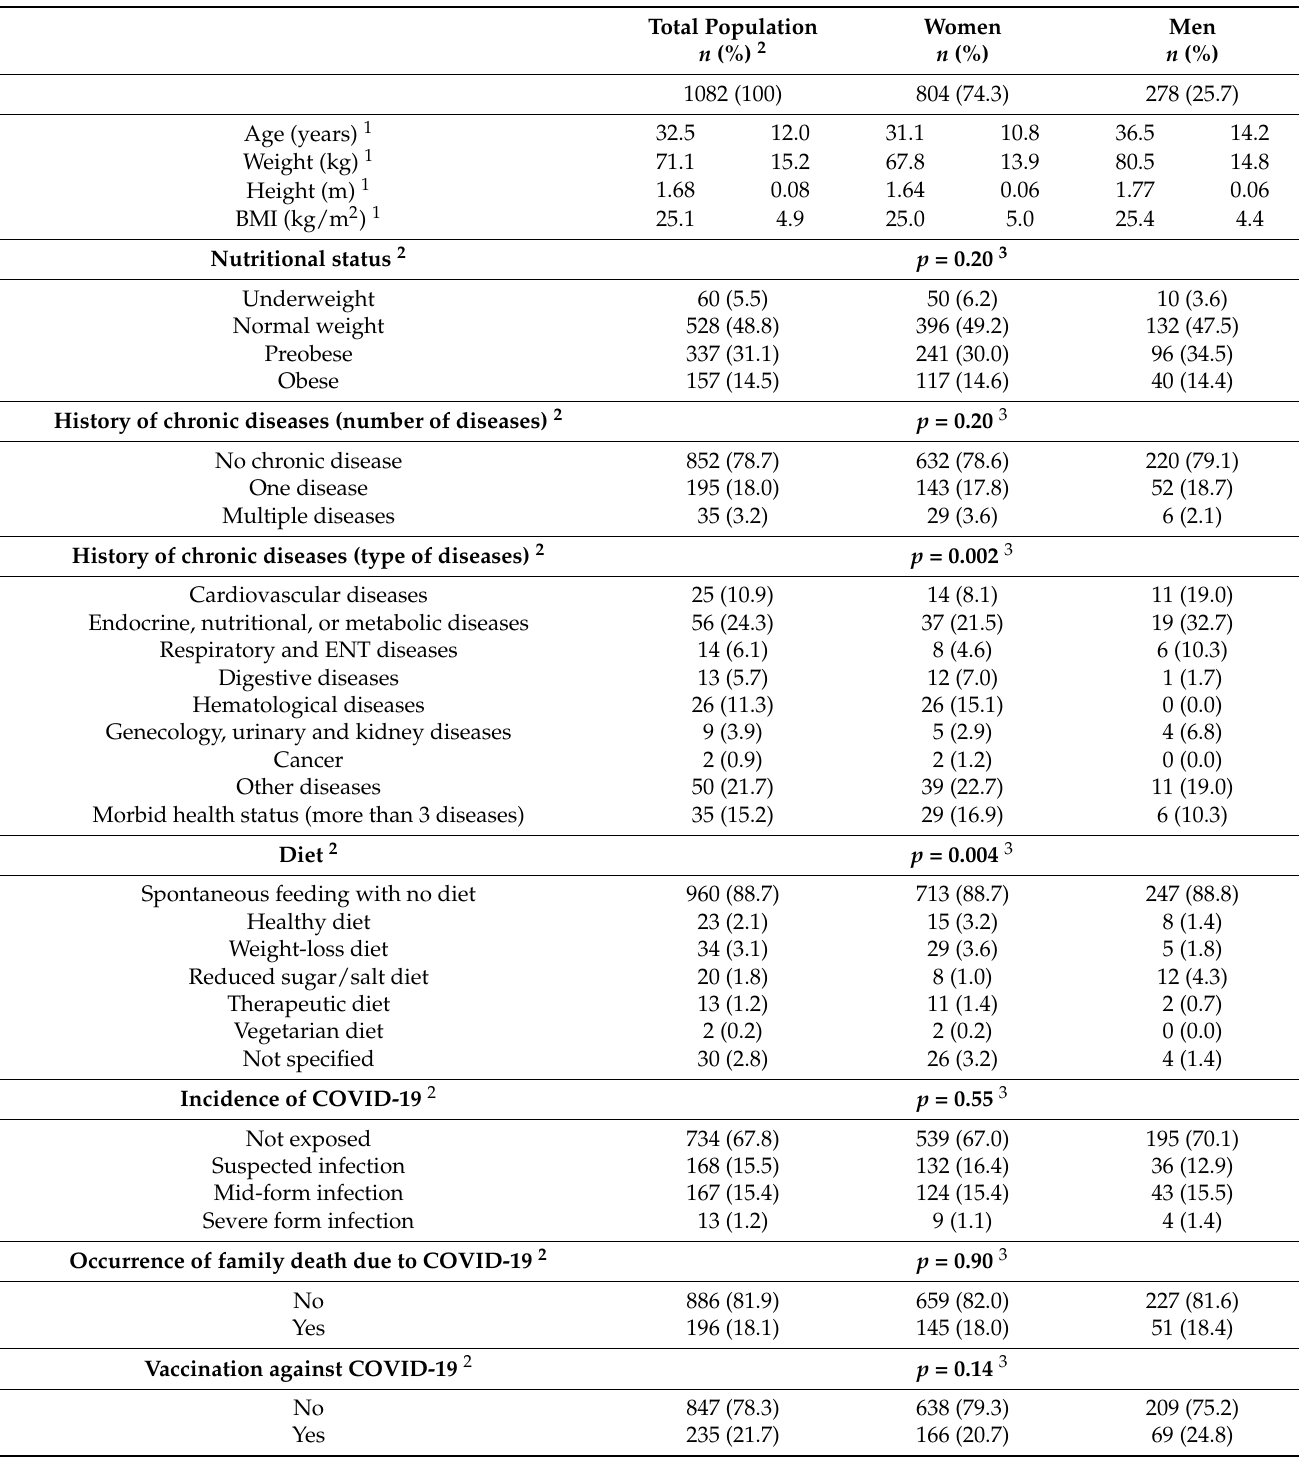
Table 2. Anthropometrics and medical data of the